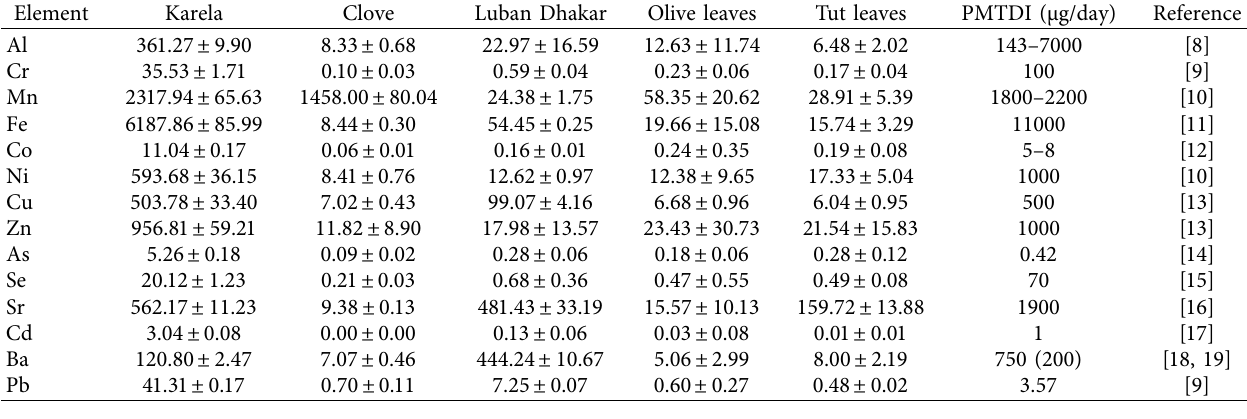
Table 4: Exposure ( µ g) to each element related to a specific plant, based on the number of grams used in each dose of a plant. Provisional maximum tolerable daily intake (PMTDI). Element